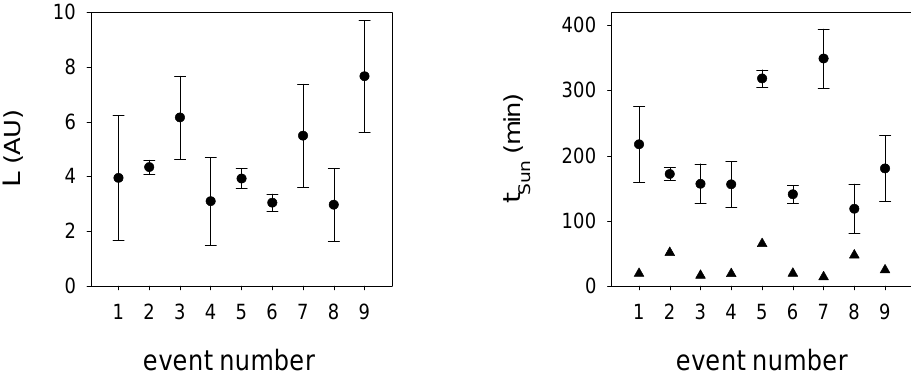
Fig. 4. Values of path length L and release time t Sun obtained from fitting of the onset times curves, versus event number. Ulysses data points are circles and Wind are triangles. The error bars for Wind data points are smaller than the size of the triangles. Release times are in minutes from the onset of the SXR flare.